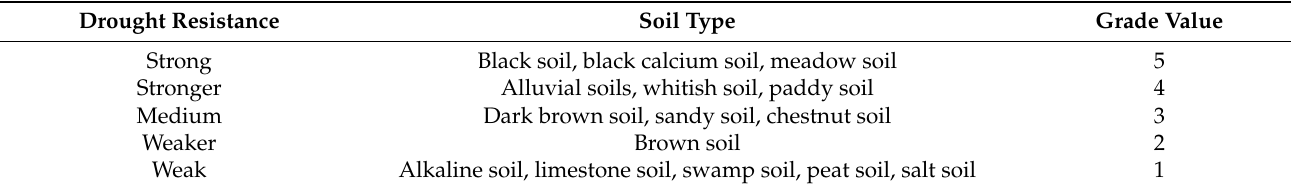
Table 4. Drought resistance of soil type in study